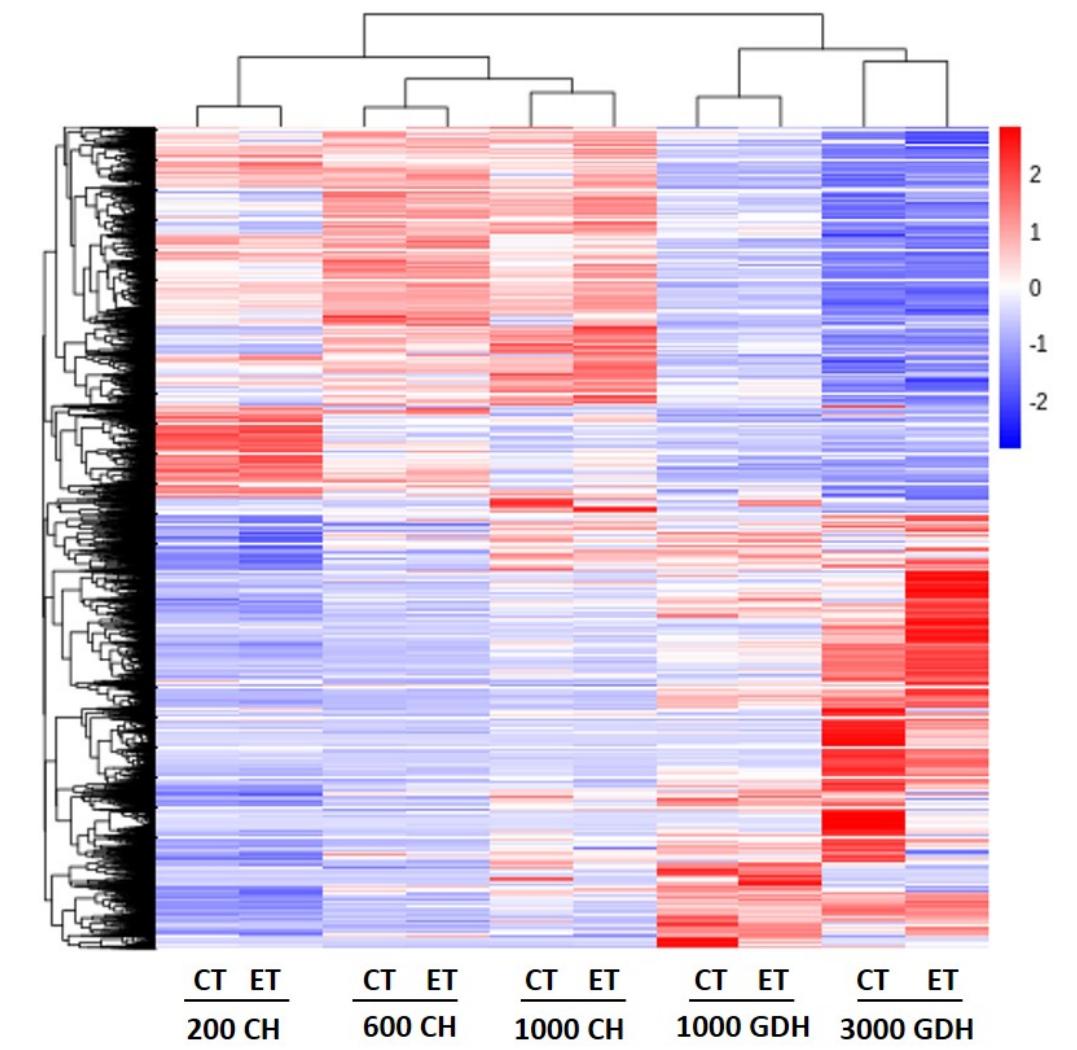
Figure 3. Hierarchical clustering analysis of all peach genes. Each datapoint consists of the expressions (FPKM) of three biological replicates. Red indicates high relative gene expression and blue indicates low relative gene expression. CT, control; ET, ethephon treatment.